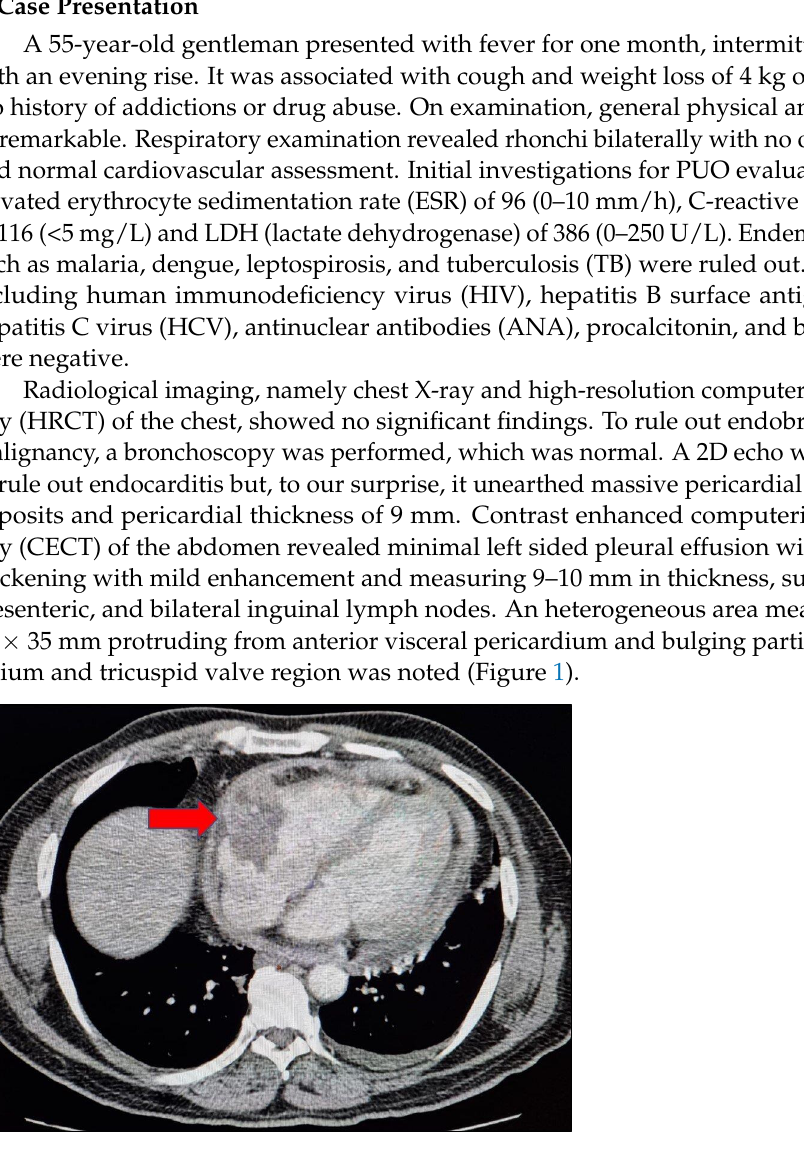
Figure 1. Mediastinal axial view of the thorax showing pericardial thickening and heterogeneous area protruding from anterior visceral pericardium and bulging partially into right atrium and tricuspid valve region.